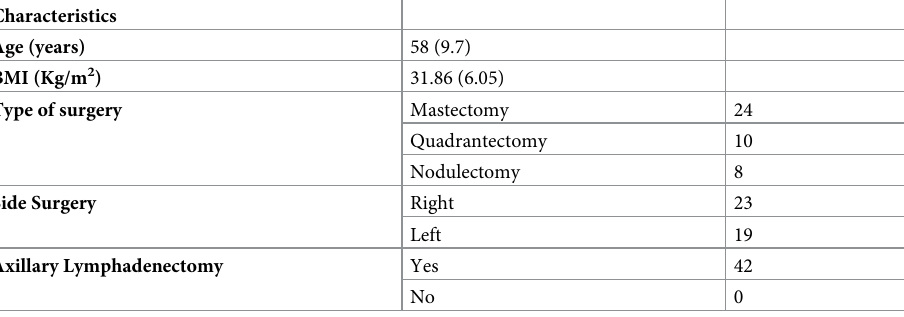
Table 1. General characteristics of patients with lymphedema.